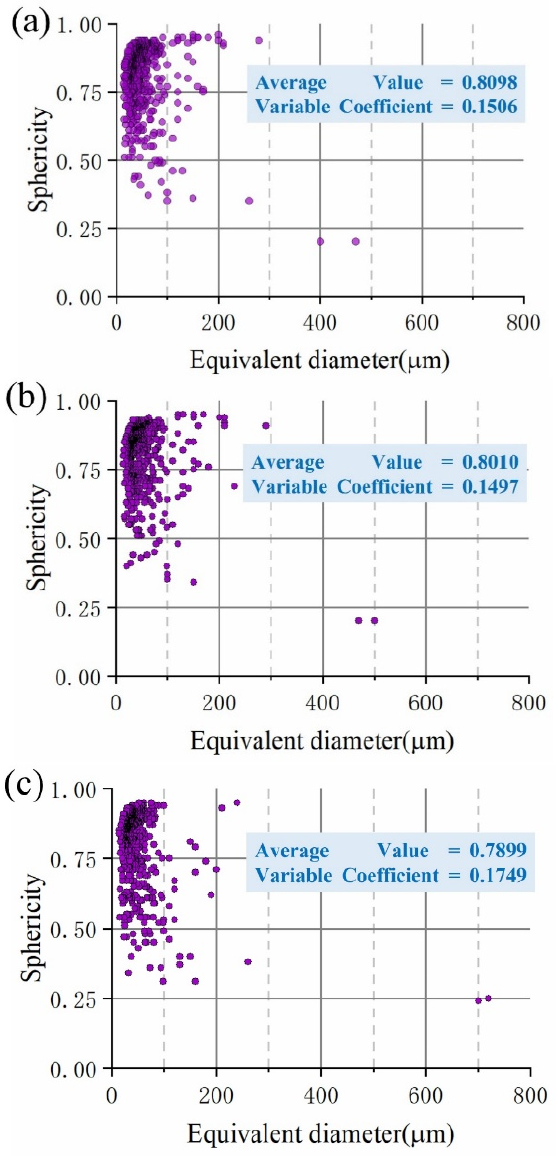
Figure 10. Sphericity distribution of defects at solder joints under different deformation states: ( a ) 0.00; ( b ) 2.77%; ( c ) 13.46%.